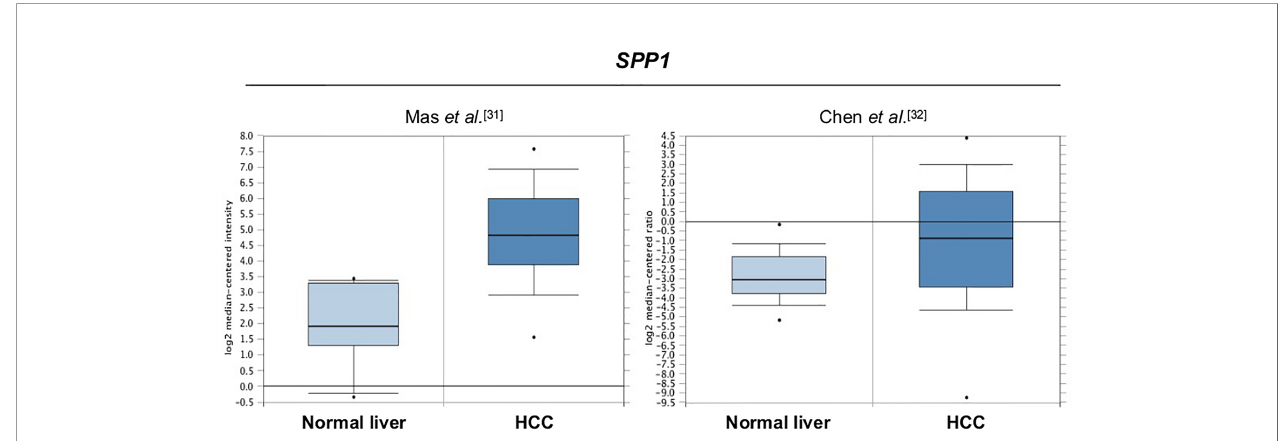
( Figure 1 ). To facilitate a comparison between human HCC and